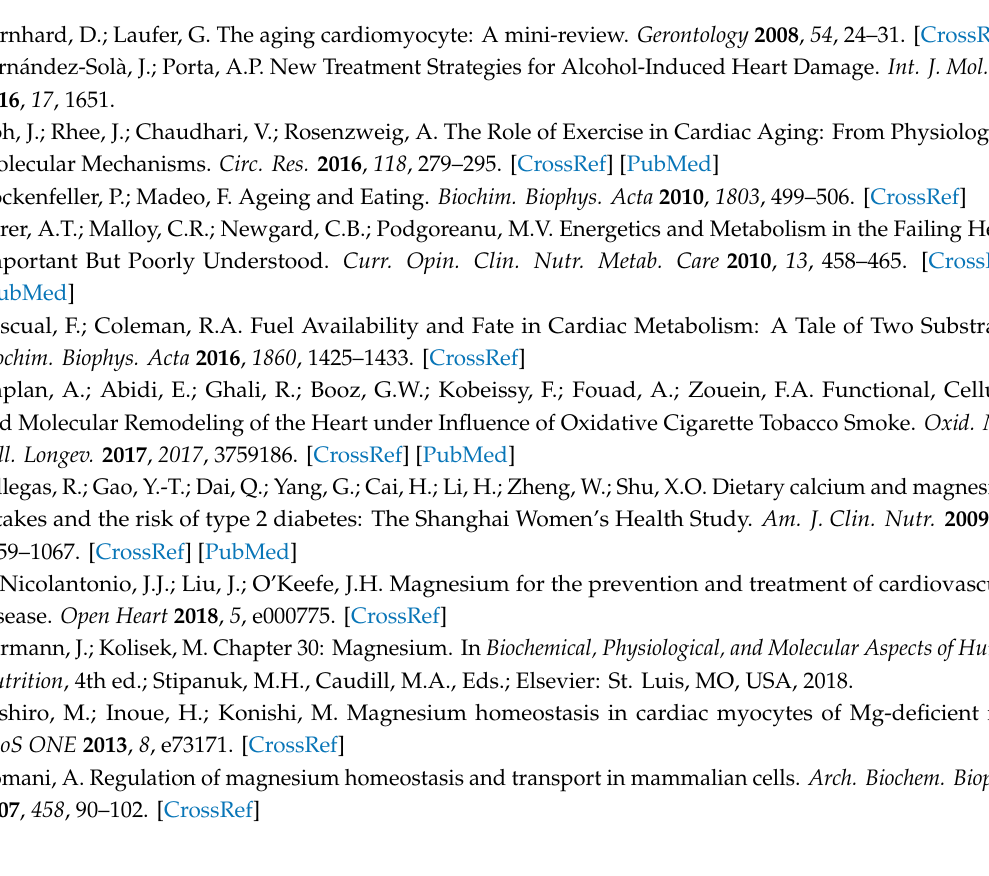
Figure A9. Representative Western blot (WB) documenting purity of isolated mitochondria from cardiac cells of Slc41a1 +/+ and Slc41a1 − / − animals on either NMgD or LMgD. Mitochondria fraction Western blot (MF-WB) cocktail (Abcam ab139416; containing antibodies against ATP5A (MW = 60 kDa; mitochondrial fraction (MF) marker, red color code), GAPDH (MW = 36 kDa; cytosolic fraction (CF) marker; blue color marker), and histone H3 (MW = 17 kDa; nuclear fraction (NF) marker; green color code). Abbreviations: LMgD, low Mg diet; M, marker; NMgD, normal Mg diet.